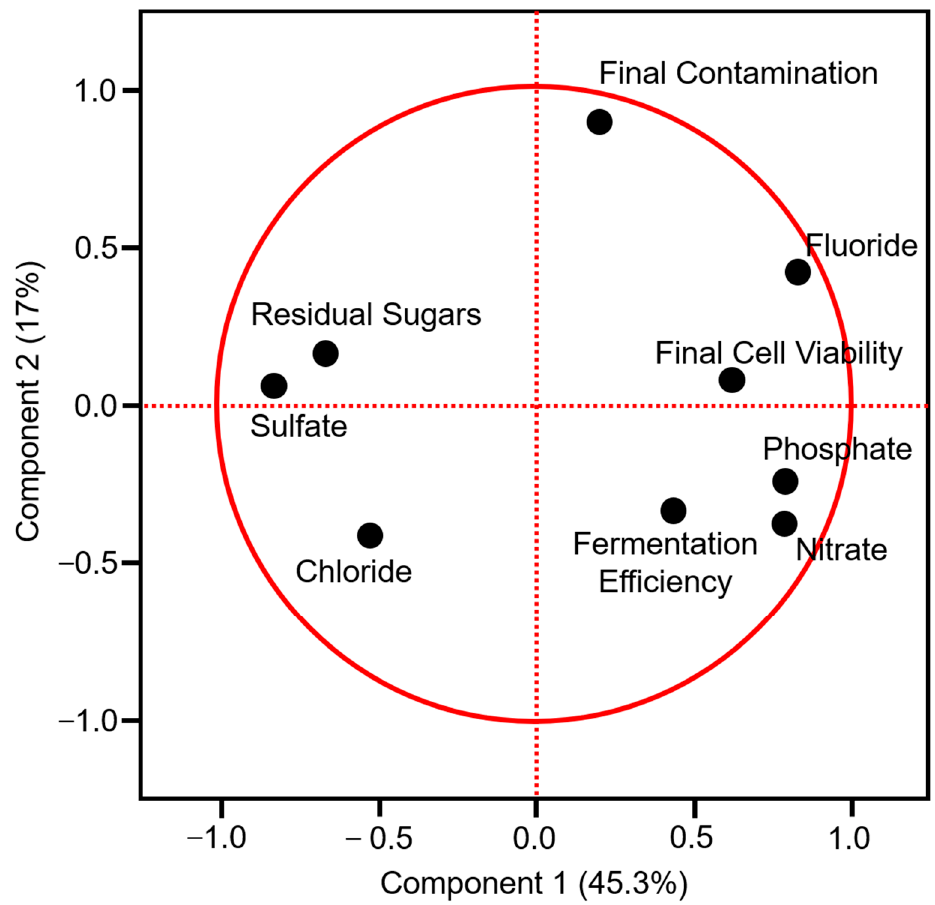
Figure 2. Principal component analysis (PCA) on correlations of fermented substrates parameters of corn ethanol (CT) and corn ethanol integrated with energy cane (PT) and fermentation effi- ciency.